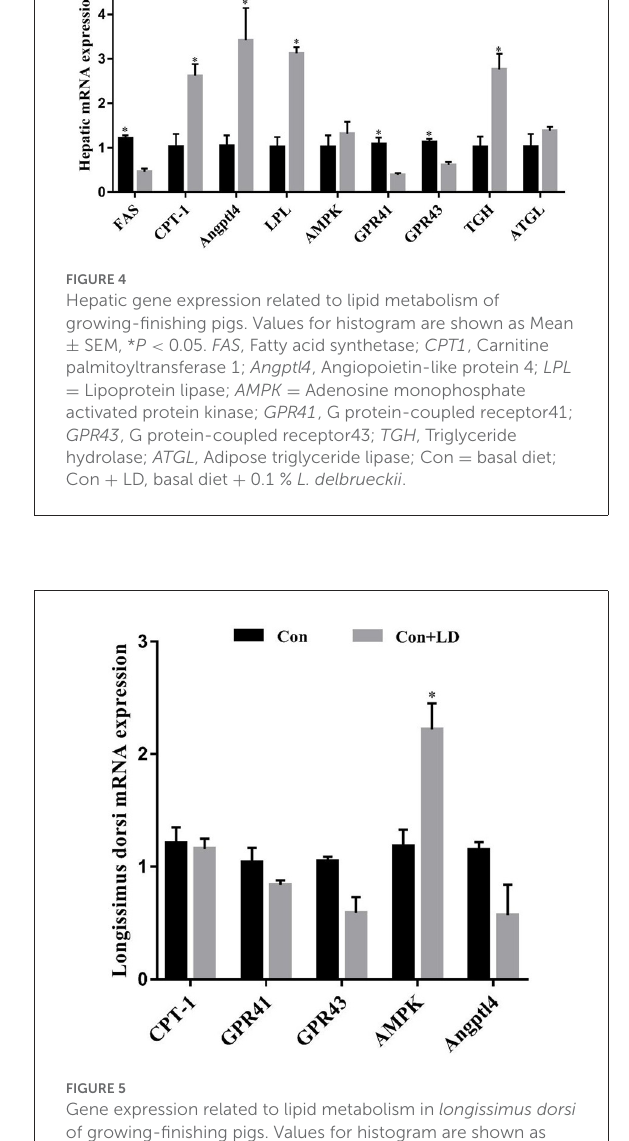
FIGURE5 Gene expression related to lipid metabolism in longissimus dorsi of growing-finishing pigs. Values for histogram are shown as Mean ± SEM, * P < 0.05. CPT1 , Carnitine palmitoyltransferase 1; GPR41 , G protein-coupled receptor41; GPR43 , G protein-coupled receptor43; AMPK , Adenosine monophosphate activated protein kinase; Angptl4 , Angiopoietin-like protein 4; Con, basal diet; Con + LD, basal diet + 0.1 % L. delbrueckii